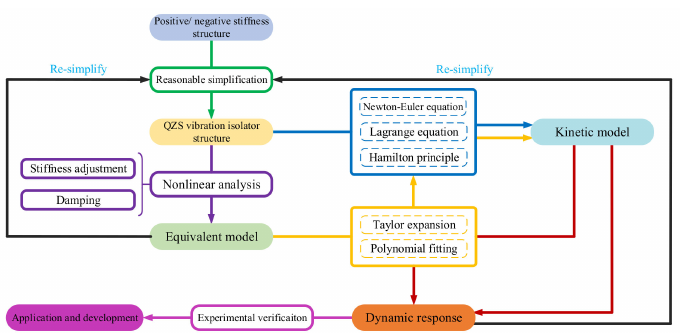
Figure 7. Process of research on QZS vibration isolation systems: design and